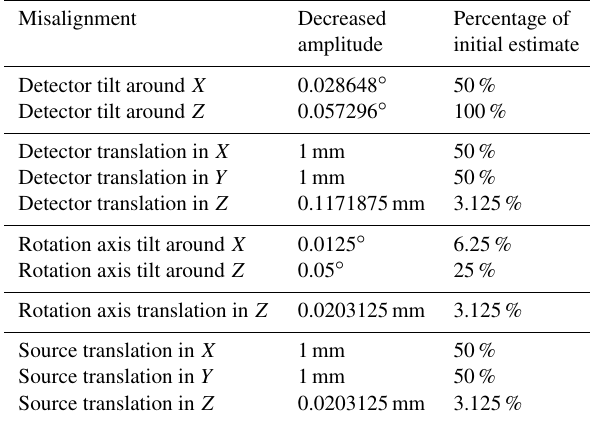
Table 2. Overview of decreased amplitudes of static geometrical misalignments to yield maximum SD errors within 10–20µm. For a comment on the omission of the detector tilt around Y and the rotation axis tilt around Y , see the explanation in Sect.